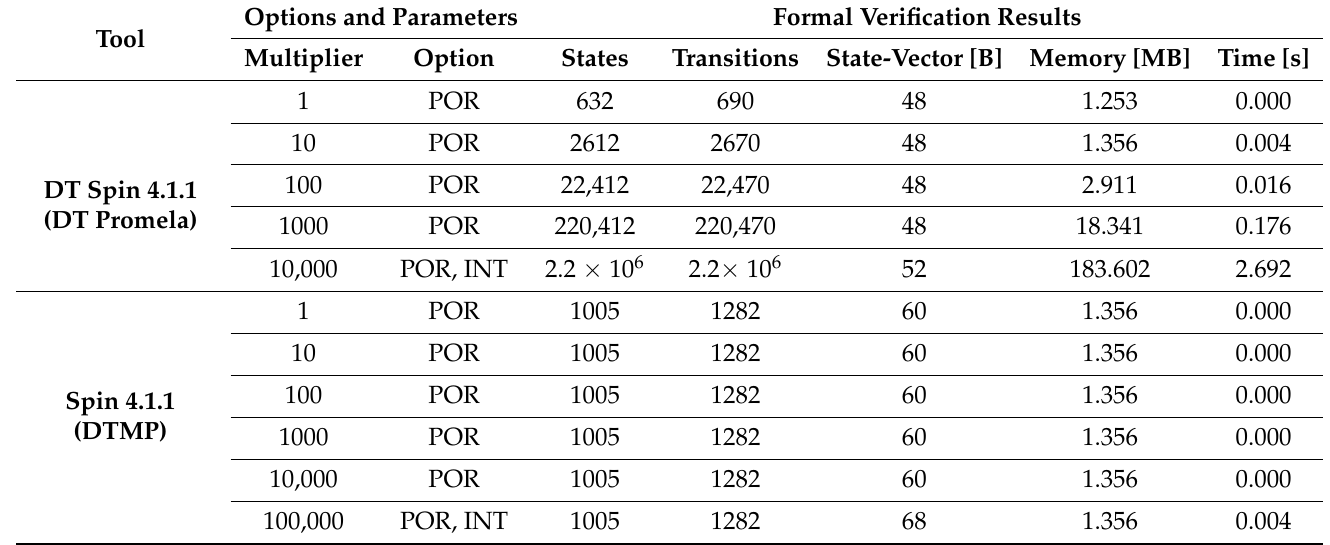
Table 2. Results for the Parallel Acknowledgment with Retransmission for DT Promela and